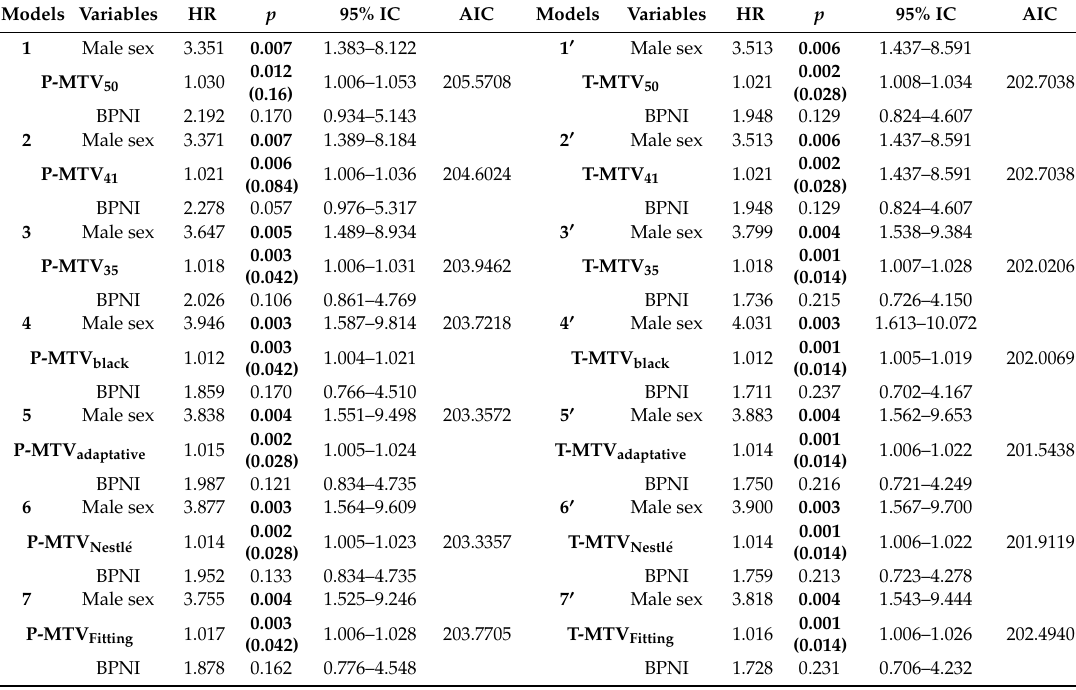
Table 3. Multivariate Cox analysis for pretreatment MTV (P-MTV and T-MTV) associations with EFS. Bold indicates a statistically significant